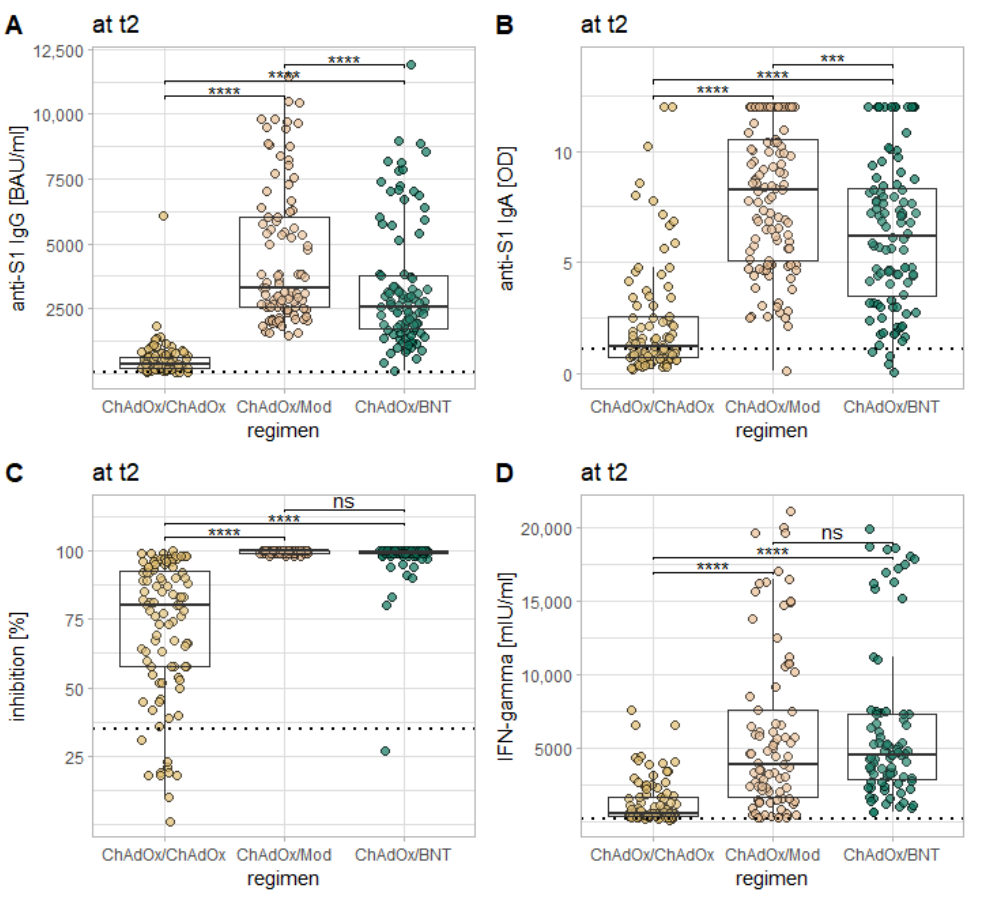
Figure 5. Comparison of the examined immune responses 14 days after the second vaccination in between the three vaccination regimes in the current study. Each plot represents a different marker: anti-S1 IgG ( A ), anti-S1 IgA ( B ), the inhibition by neutralizing antibodies ( C ), and T-cell response as measured via IGRA ( D ). The dotted horizontal lines represent the cutoff for reactivity of the different assays. Levels of significance: * = p < 0.05; ** = p < 0.01; *** = p < 0.001; **** = p < 0.0001; ns = not statistically significant.